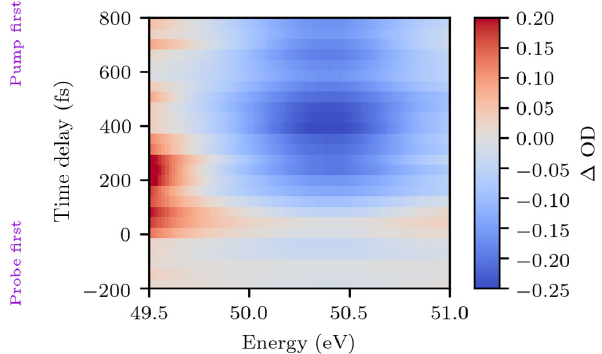
FIG. 6. Δ OD ð rec Þ ð E; t Þ , reconstructed from the absorption spectra S j ð E Þ and their contributions to the total absorbance Δ a ð t Þ ( j ¼ 0 , 1, 2, 3), which are obtained from fitting Eq. (2) to j the experimentally measured data.